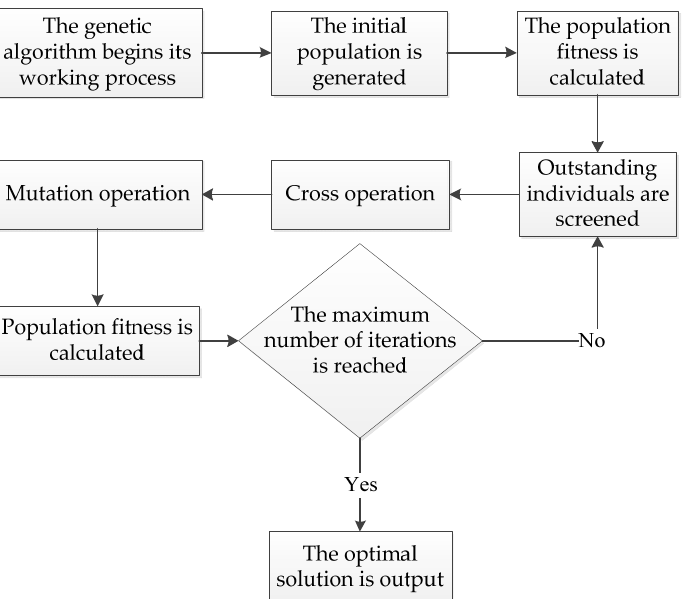
Figure 17. The solution steps of the genetic